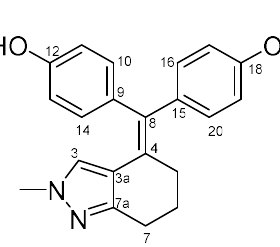
Scheme 21. Structure of 33a with the numbering of atoms used for the assignment of NMR data.